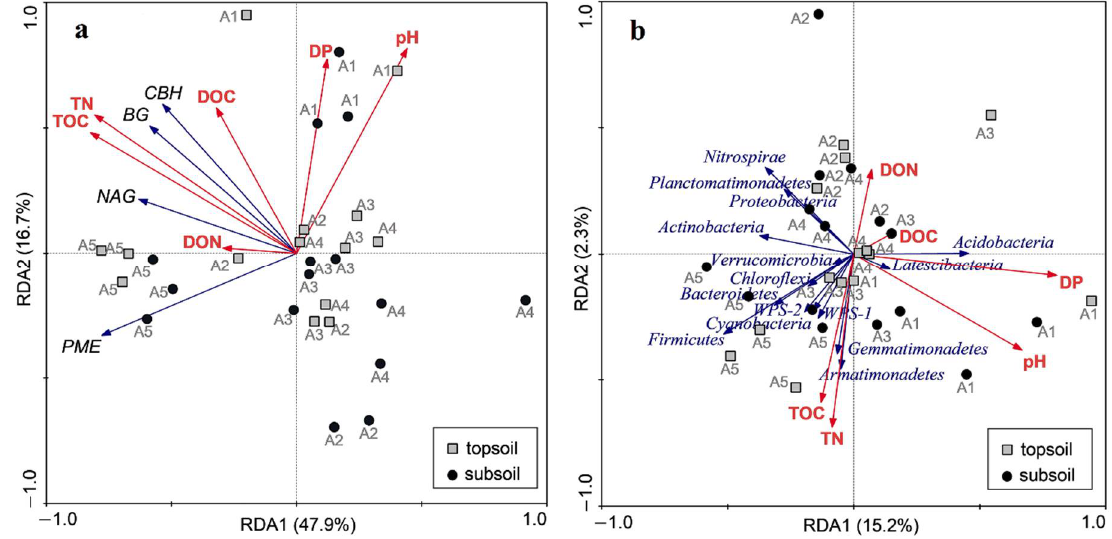
Figure 5. Redundancy analysis (RDA) of ( a ) enzyme activities and ( b ) microbial communities constrained by soil chemical parameters. Table 4. Pearson correlation coefficients between soil chemical properties, enzyme activities and microbial communities.